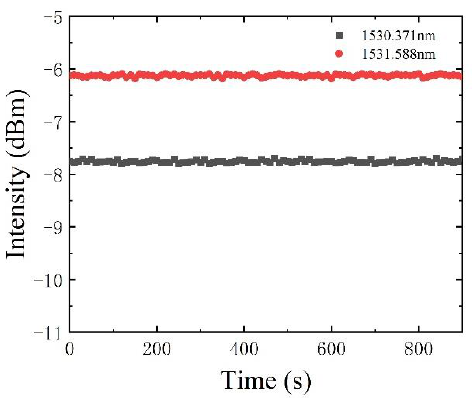
Figure 8. The output power stability of the intracavity absorption gas sensor network.